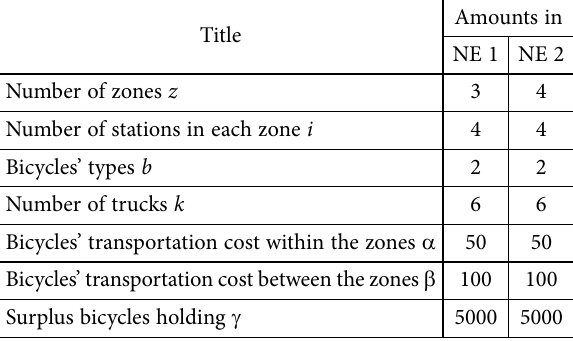
Table 2. Dimension of the 2 numerical examples